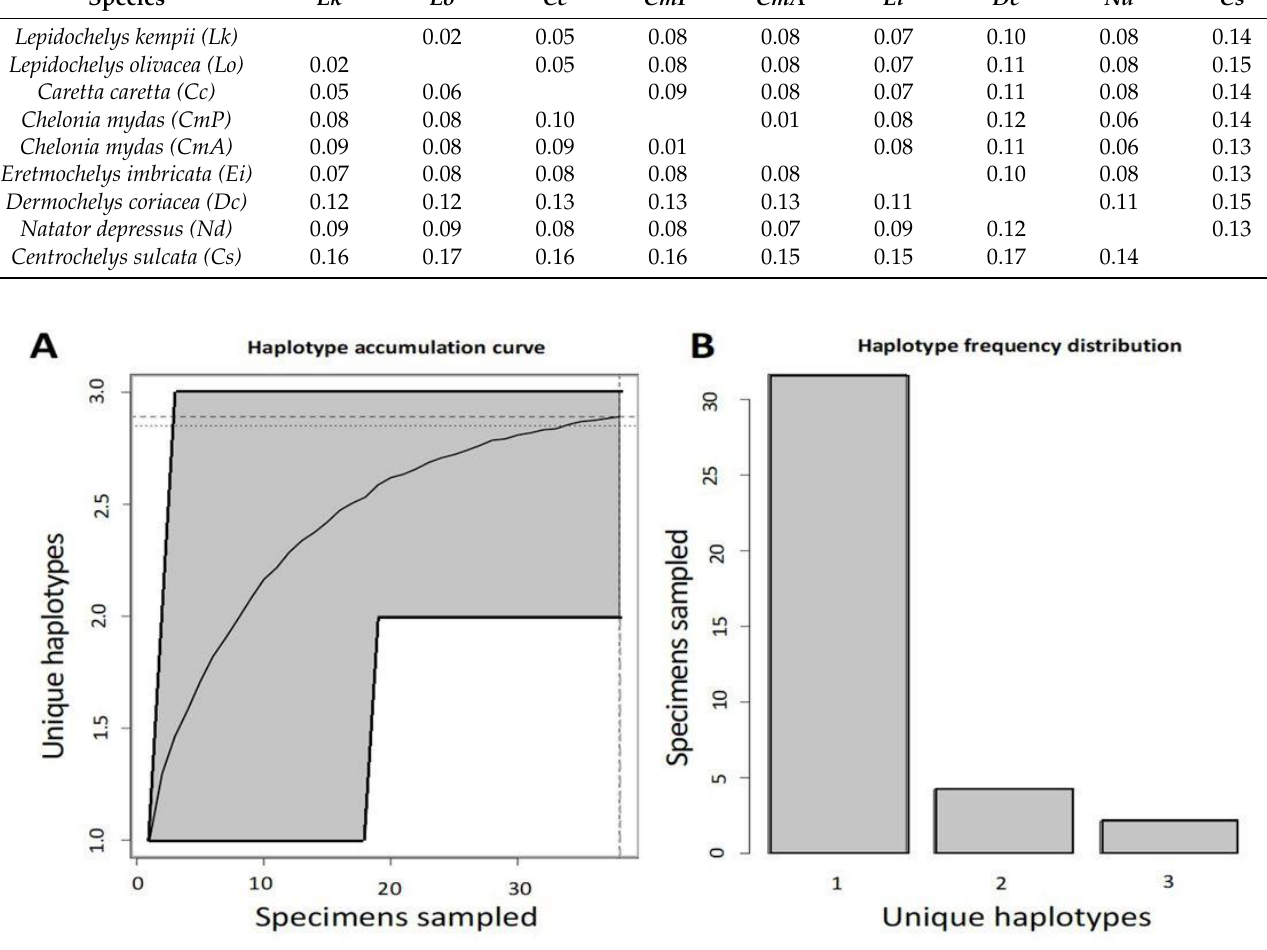
Figure 4. Haplotype accumulation curve. ( A ) Haplotype accumulation curve; ( B ) Haplotype fre- quency distribution. The data obtained were made using the HACSim function in the R package with 1000 permutations (Phillips et al., 2020).